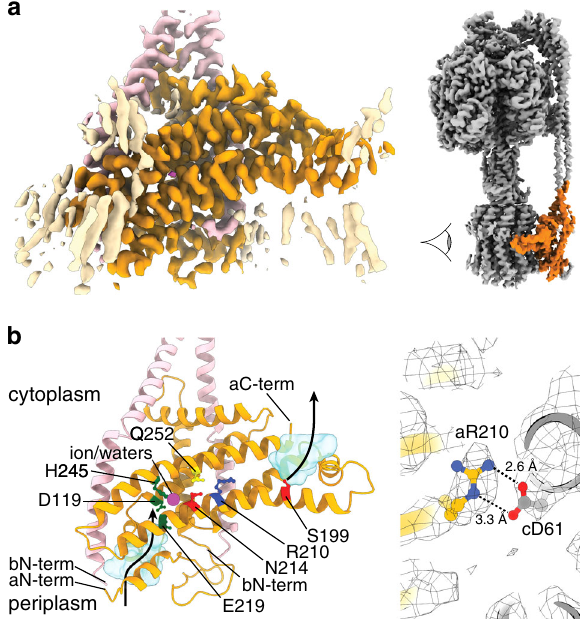
Fig. 4 The F o stator of E. coli F 1 F o ATP synthase. a Sub-state 3A F o focused cryo-EM map of the E. coli F o stator, masked to remove c-ring for clarity (subunit a in orange, subunit b in pink and lipid-like densities in wheat). Highlighted orange region in the intact enzyme on right shows area depicted, with viewpoint indicated with an eye. b Molecular model of the F o stator, as viewed from the c-ring, showing discussed residues at the stator rotor interface. Colors as in Fig. 1 (subunit a in orange and subunit b in pink) with the proton half-channels shown as light blue inverted surfaces (made with the program HOLLOW 60 ) and potential proton path shown with black arrow. Essential aArg210 27 (dark blue) is located in the center of the membrane, adjacent to cAsp61 28 (shown in c). aGln252 is situated proximally to aArg210 and function can be retained when these residues are interchanged with one another 37 . aGlu219 32 , aAsp119, aHis245 33 , and aAsn214, which are required for proton translocation, are situated between the end of the periplasmic half-channel and cAsp61, adjacent to density that could be a ion/water molecule (magenta sphere). aSer199 is situated at the beginning of the cytoplasmic proton channel. N-termini and C-termini of subunits a and b labeled.